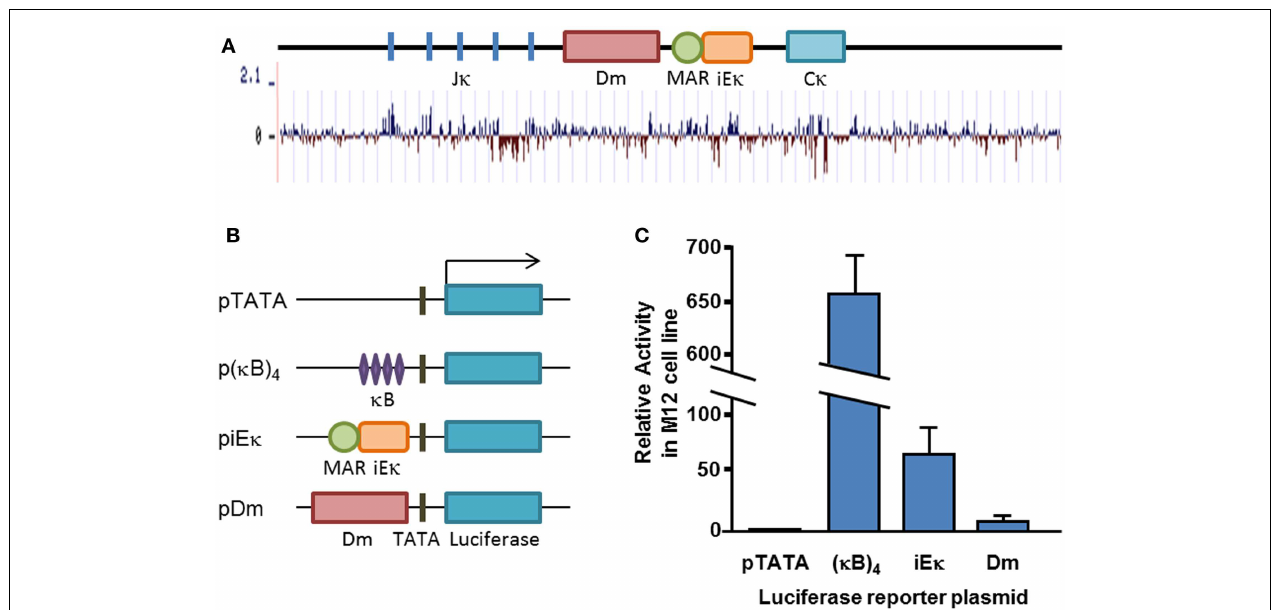
transfected with the indicated plasmids. Plasmids were co-transfected with a constitutive β -Gal-expressing plasmid and luciferase activity was normalized for transfection efficiency to β -Gal activity.Transfection and luciferase assay was carried out at least three times for each construct. Error bars represent the standard deviation of the luciferase